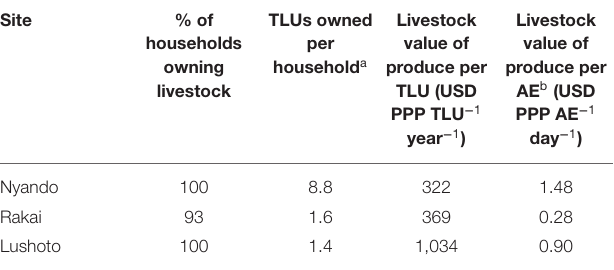
TABLE 2 | Current livestock ownership and value of produce per TLU (tropical livestock unit).